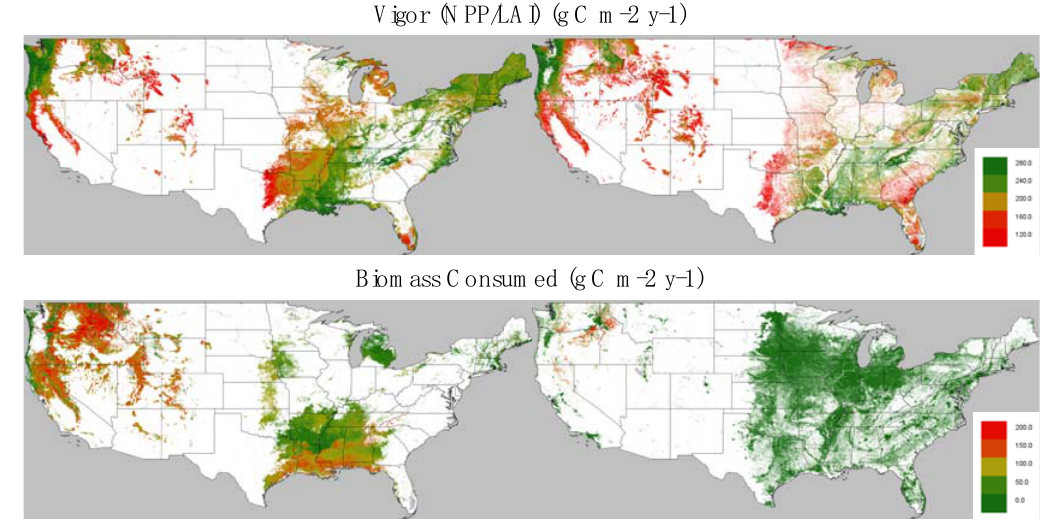
Figure 4. Factors that may decrease the value of ecosystem services across the conterminous USA: a decrease in vigor (NPP/LAI) and the amount of biomass consumed by wildfires, comparing simulation results for mid-century conditions (2041–2070), with and without land use, across 3 possible futures (climate projections from CGCM3, MIROC and CSIRO) under the A2 emission scenario. Projected vigor is mapped where forest production is projected to be the highest and simulated carbon losses to wildfires are mapped where carbon sequestration is expected to be the greatest by mid-21st century. Simulation results were obtained by running the MC2 model at 30 arcsec spatial resolution.